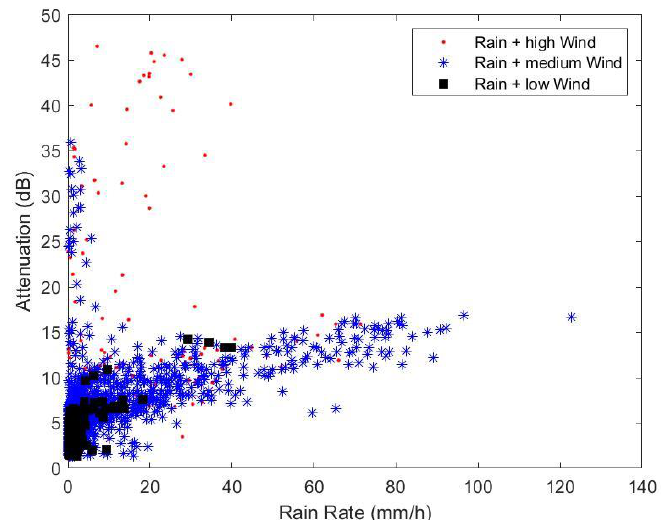
Figure 9. Maximum attenuation in 1-min intervals as a function of the rain rate of three groups of data: high wind speed, medium wind speed, and low wind speed.